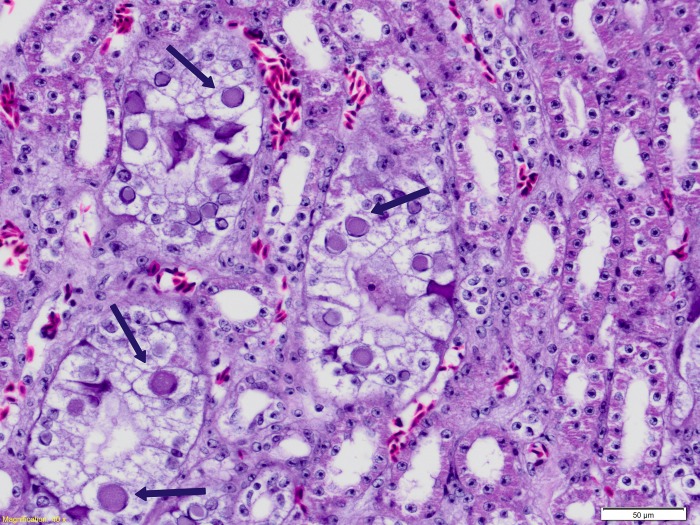
Light microscopic image of haematoxylin and eosin stained kidney tissue from an orange-bellied parrot that died at the Adelaide Zoo with aspergillosis and a Psittacid Adeonvirus-2 infection.Characteristic adenovirus associated intra-nuclear inclusion bodies (Arrows) are shown in renal collecting duct epithelial cells.